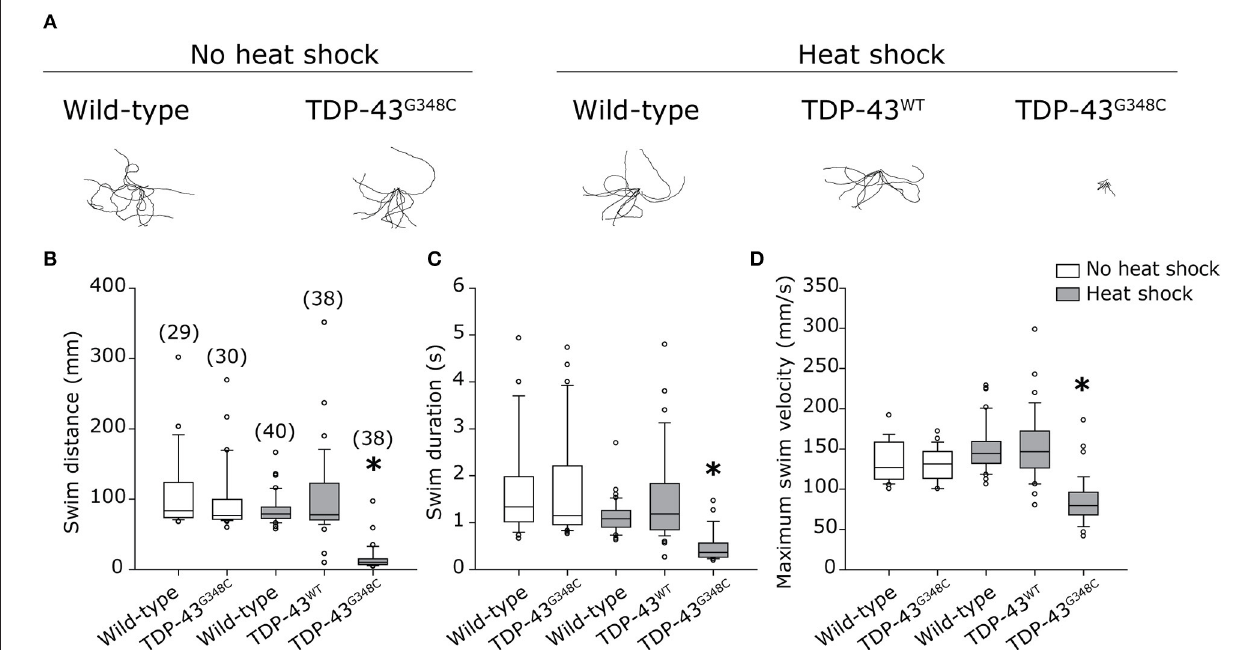
FIGURE 2 | Zebrafish embryos expressing TDP-43 G348C display an abnormal touch-evoked locomotion at 2 dpf. (A) Overlay of 10 representative swim traces obtained after lightly touching the tail of 2 dpf embryos with a blunt forceps. Embryos expressing TDP-43 G348C exhibited a significantly reduced swim distance (B) , swim duration (C) and maximum swim velocity (D) , compared to embryos expressing TDP-43 WT or not expressing any transgene. All experiments were done in triplicate; the total number of embryos used is indicated in brackets. Kruskal-Wallis one-way analysis on variance on ranks was performed and pairwise multiple comparison procedures were done according to Dunn’s method. * p -value <